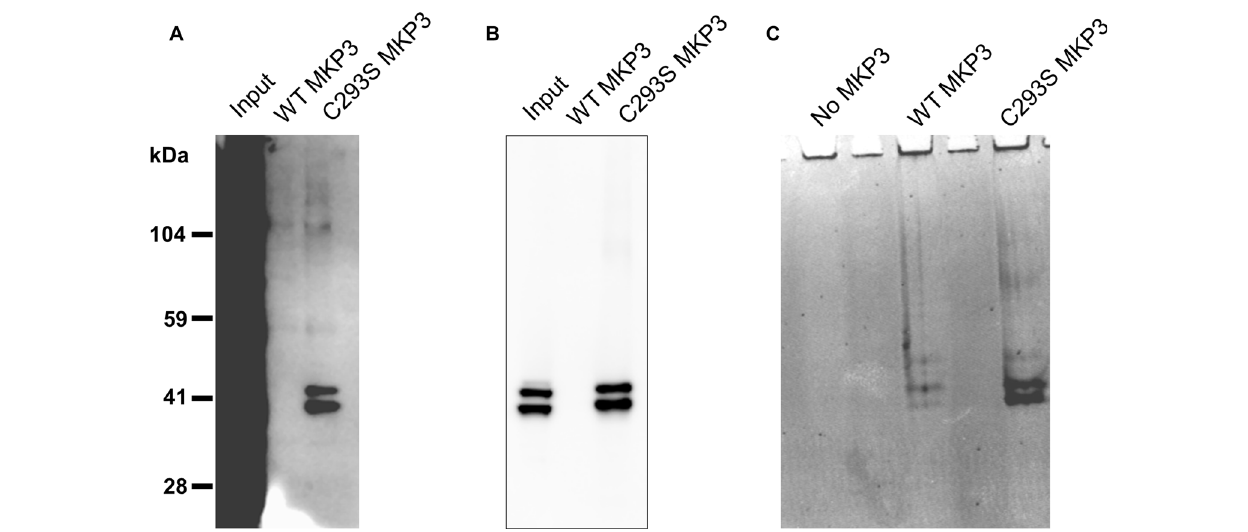
FIGURE 5 | Substrate trapping reveals ERK1/2 as the major substrates for MKP3. PC12 lysate was incubated with WT MKP3 or substrate trapping mutant C293S MKP3, followed by isolation of MKP3 and elution of co-precipitated proteins. Eluted proteins were subjected to western blotting with (A) phospho-tyrosine antibody, (B) phospho-ERK1/2 antibody or the gel was stained with Coomassie stain (C) . The blots show that MKP3 efficiently captures ERK1/2 but does not reveal other kinases or proteins to be substrates for